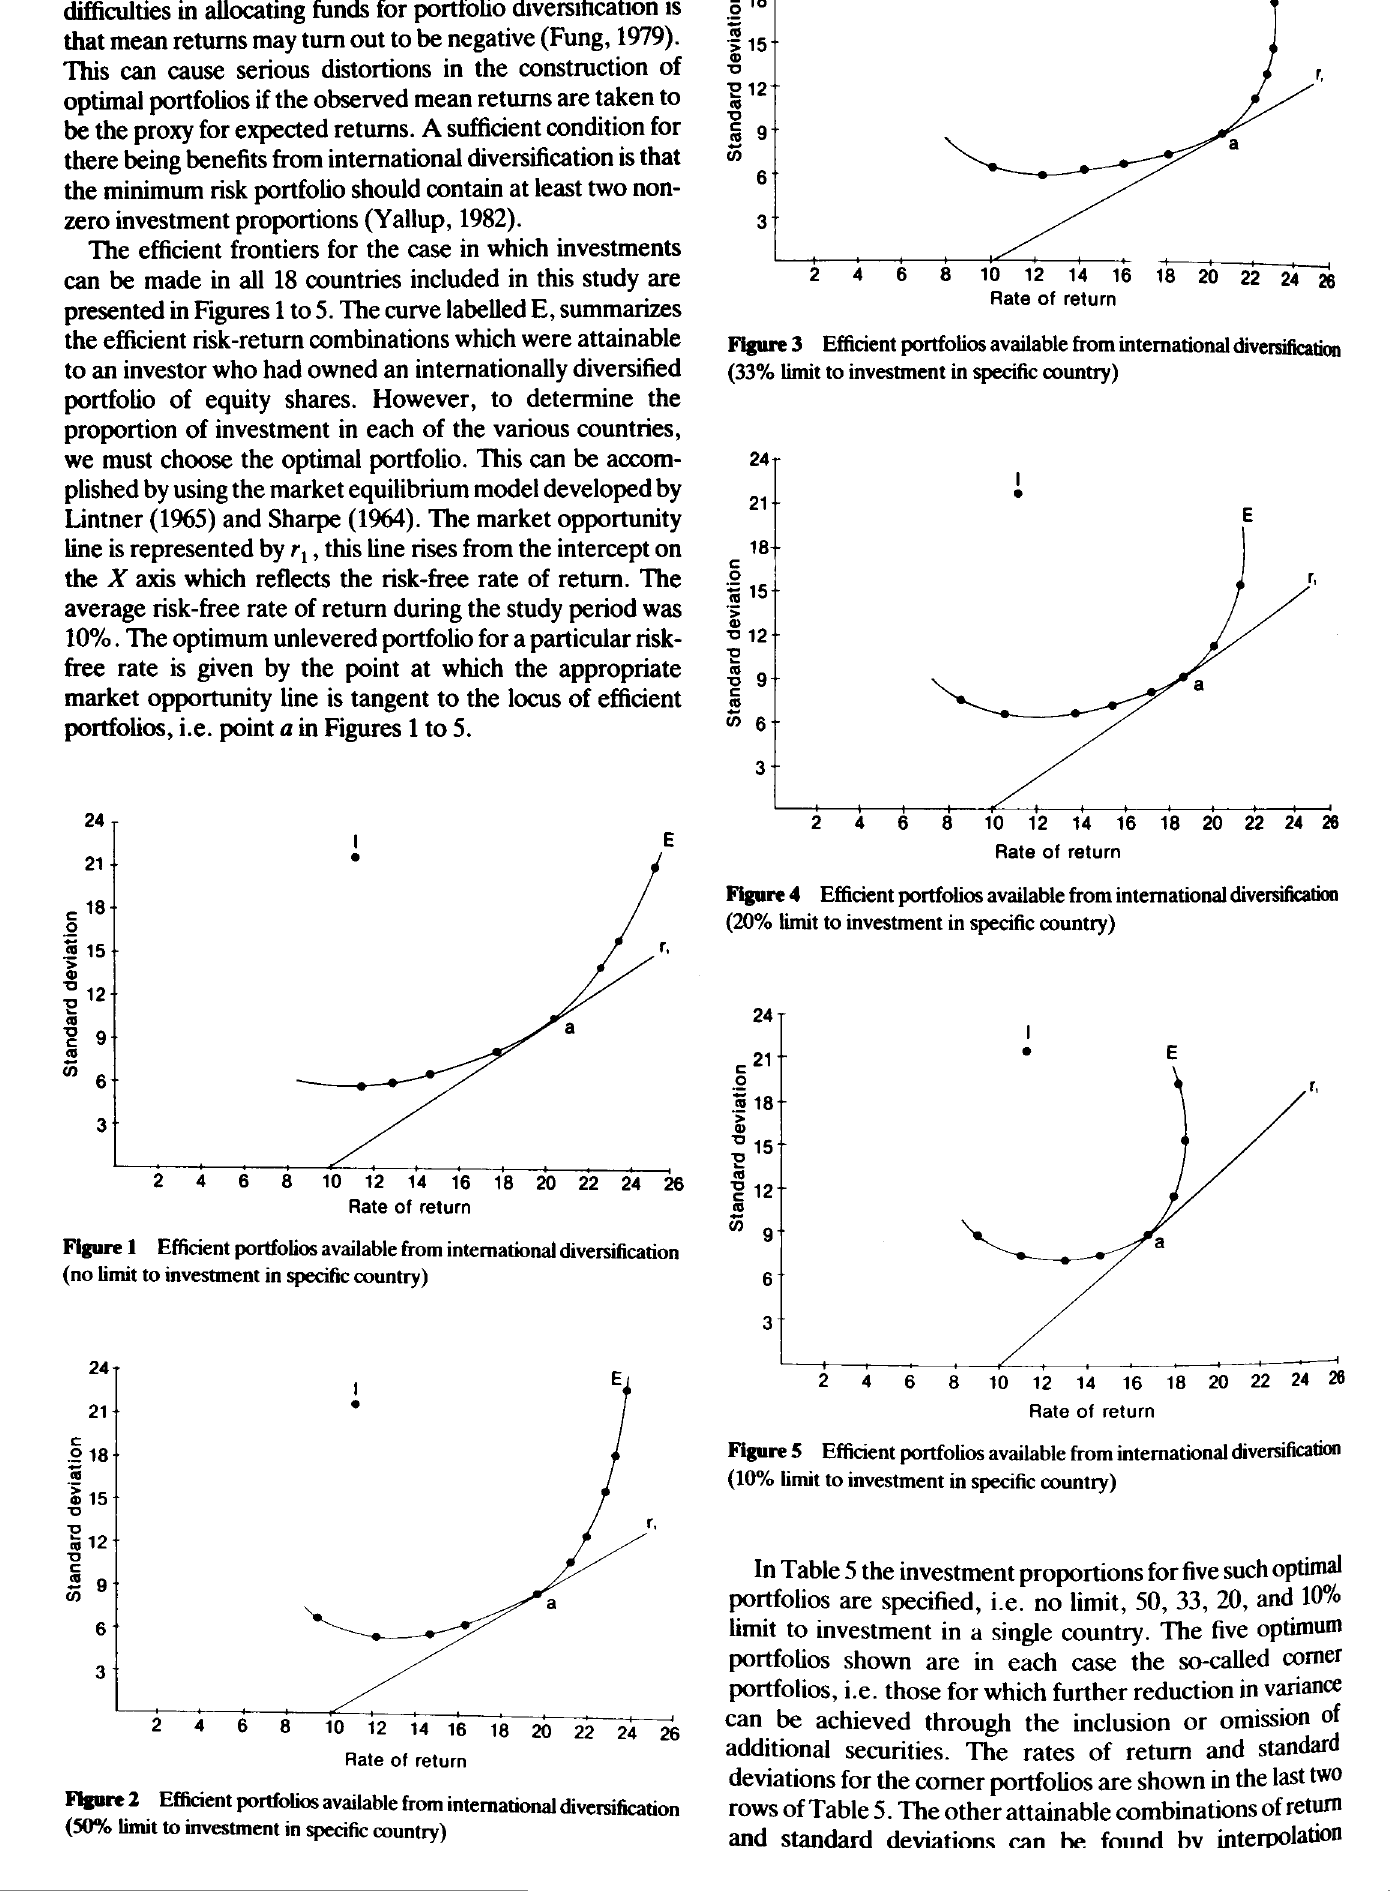
deviations for the corner portfolios are shown in the last two rows of Table 5. The other attainable combinations of